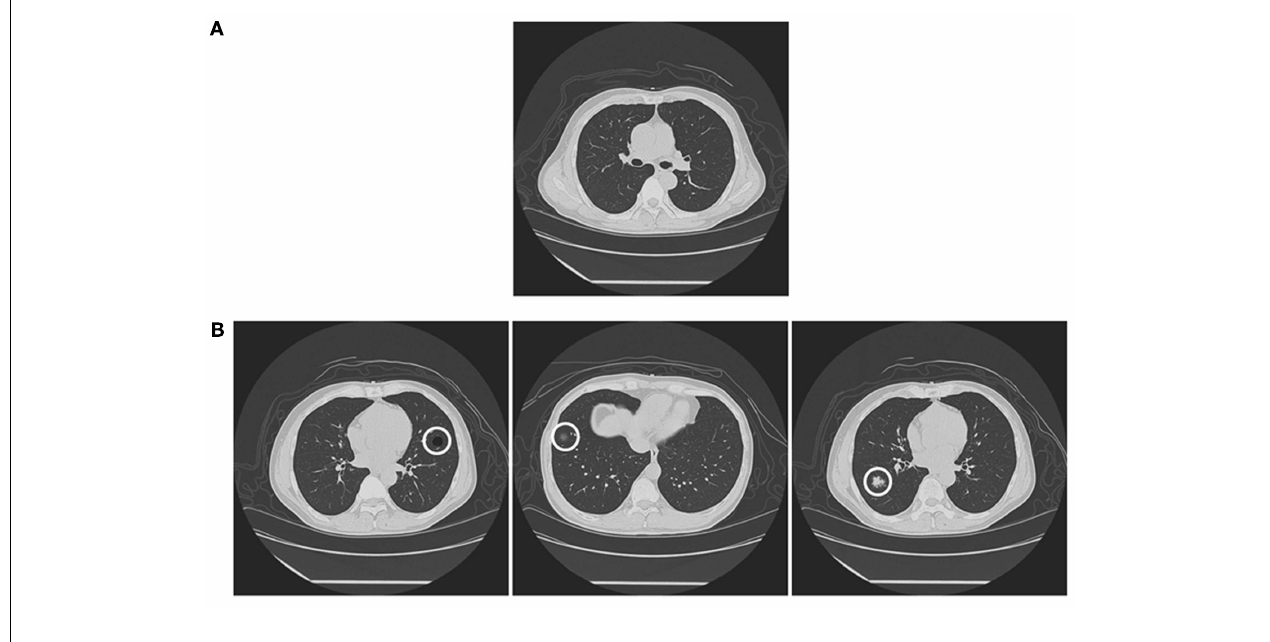
and a cancer-present image (Right). Each target lesion is marked by a white ring in this figure. Note; the white ring was not presented in the